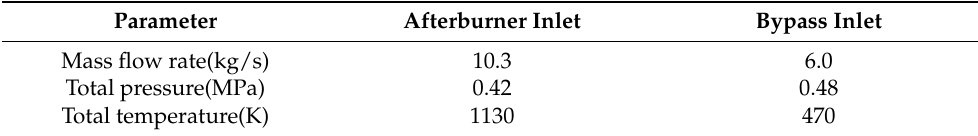
Table 2. Boundary